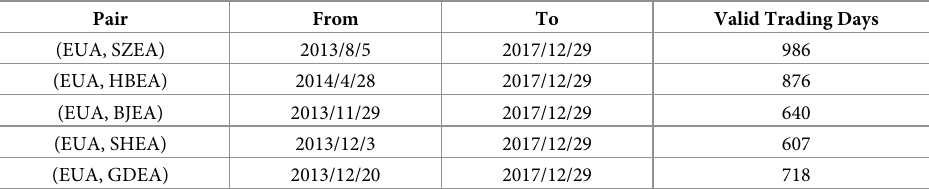
Table 2. Data period selection for the EU ETS and China’s carbon trading pilots. Pair From To